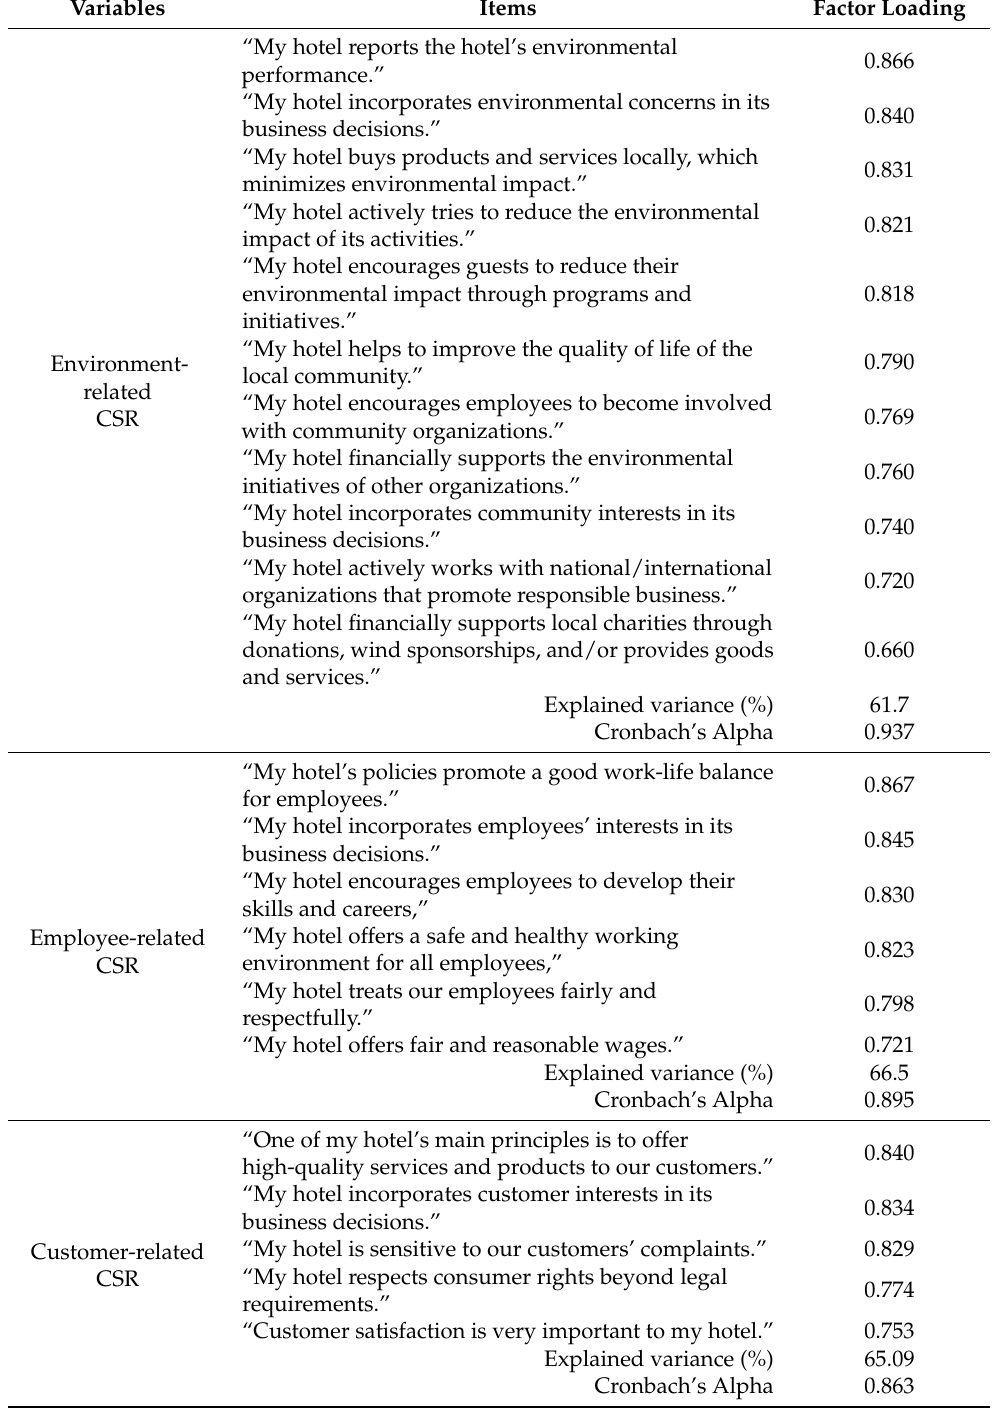
Table 2. Exploratory factor